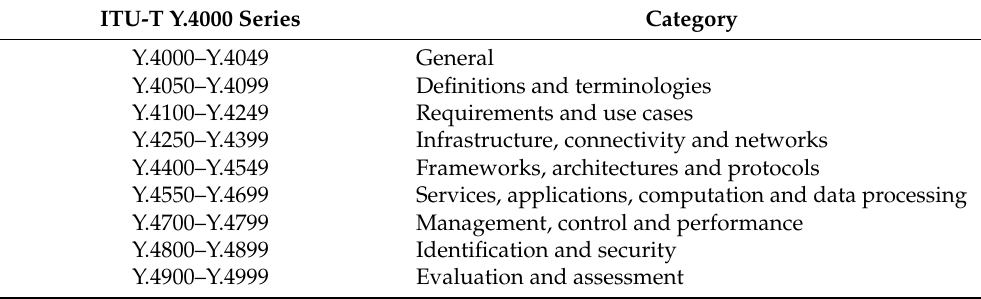
Table 1. ITU-T SG20 key standardization areas in IoT and Smart Sustainable